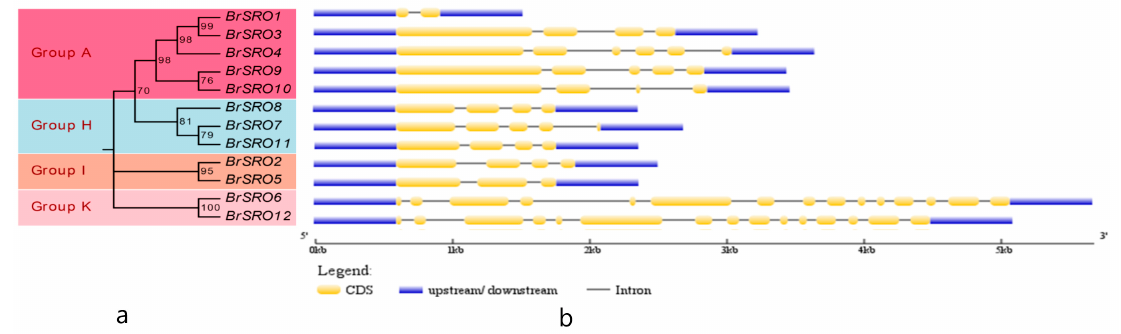
Figure 3. Compositions of introns and exons of BrSRO genes based on the phylogenetic relations. The amino acid sequences of the SRO proteins were aligned with ClustalX, and the phylogenetic tree was constructed using the neighbor joining method in MEGA 7.0 software ( a ). Each node is represented by a number that indicates the bootstrap value for 1000 replicates. The right side illustrates the exon-intron organization of the corresponding SRO genes. The exon and intron are represented by the yellow boxes and black lines, respectively. The scale bar represents 1 kb ( b ). The blue boxes represented upstream/downstream.